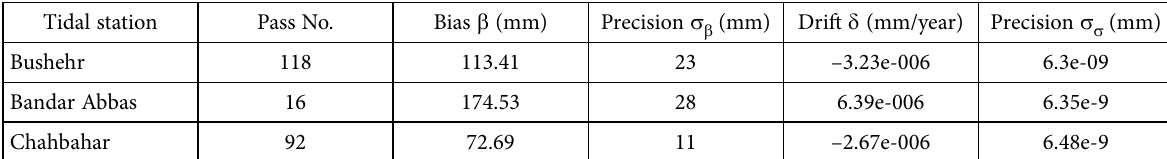
Table 4. Bias and drift of jason-1 estimated by the coastal tide gauge stations located at Bushehr, Bandar Abbas and Chabahar ports